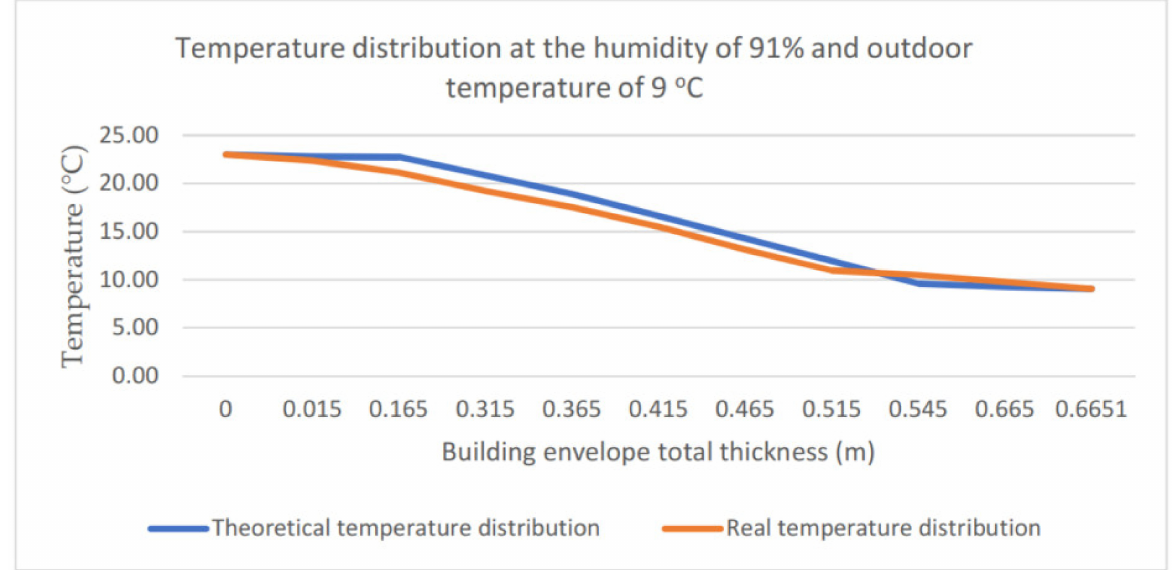
Figure 14. Temperature distribution at the humidity of 91% and outdoor temperature of 9 ◦